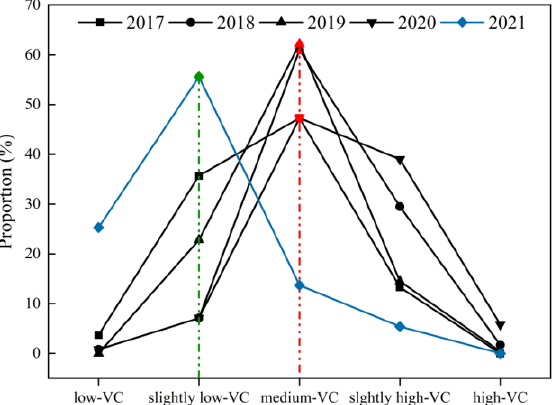
Figure 19. The proportion of different vegetation cover grades on “ground” from 2017 to 2021 .